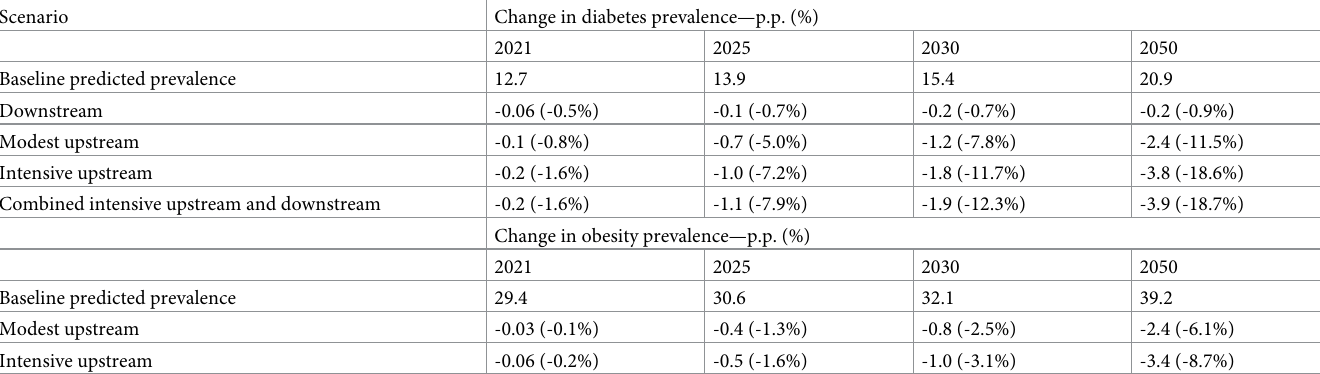
Table 3. Change in diabetes and obesity prevalence from combined scenarios compared to the baseline prediction. Scenario